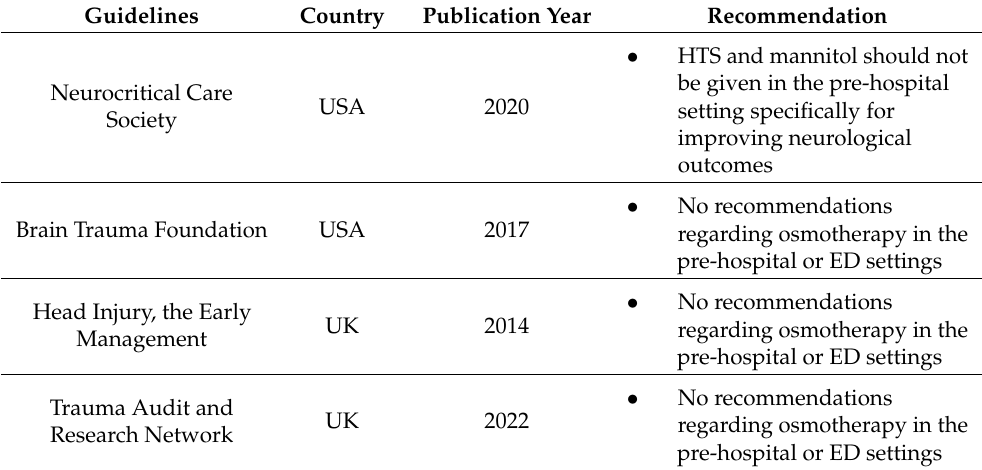
Table 2. Summary of guideline recommendations for osmotherapy in the pre-hospital and ED